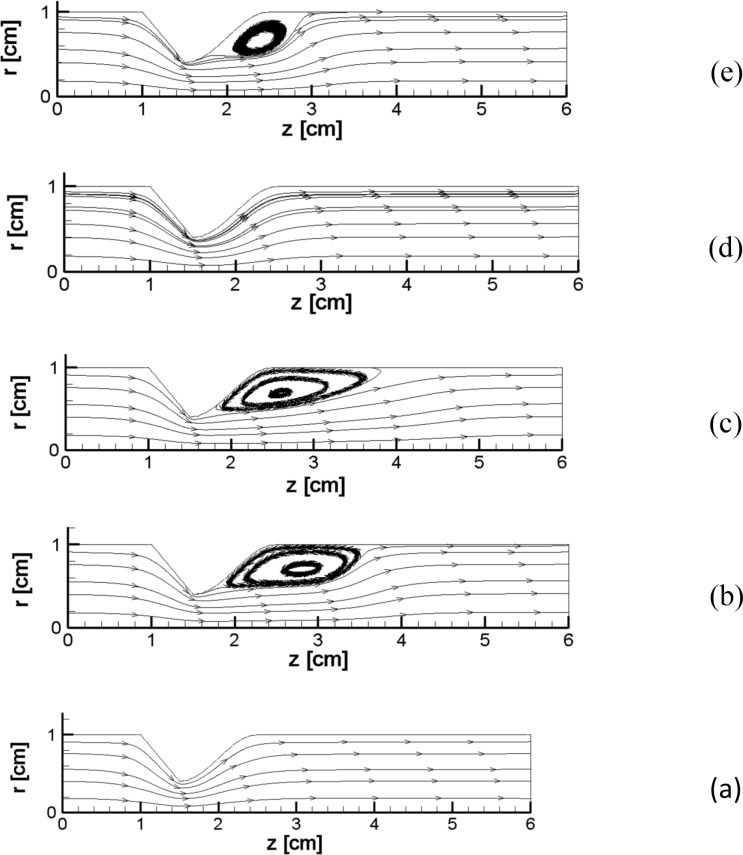
(a) to (e). This figure represents recirculation after the stenosis for the case of 60 percent stenosis with a low pressure gradient and Joule heating (a) t = 0 s (b) t = 0.25 s (c) t = 0.5 s (d) t = 0.75 s (e) t = 1 s, Lvessel = 6 cm, Rvessel = 1 cm and a fifty percent stenosis.